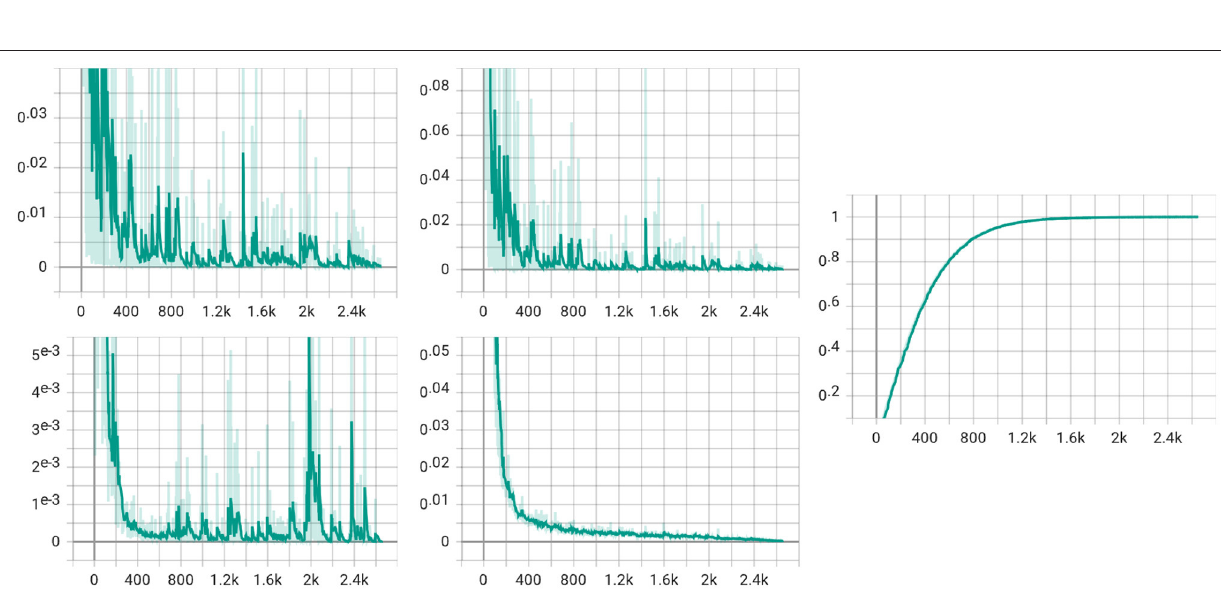
Figure 9 , each color stands for a source domain, and the target domain are in black. To better plotting, we transparent the